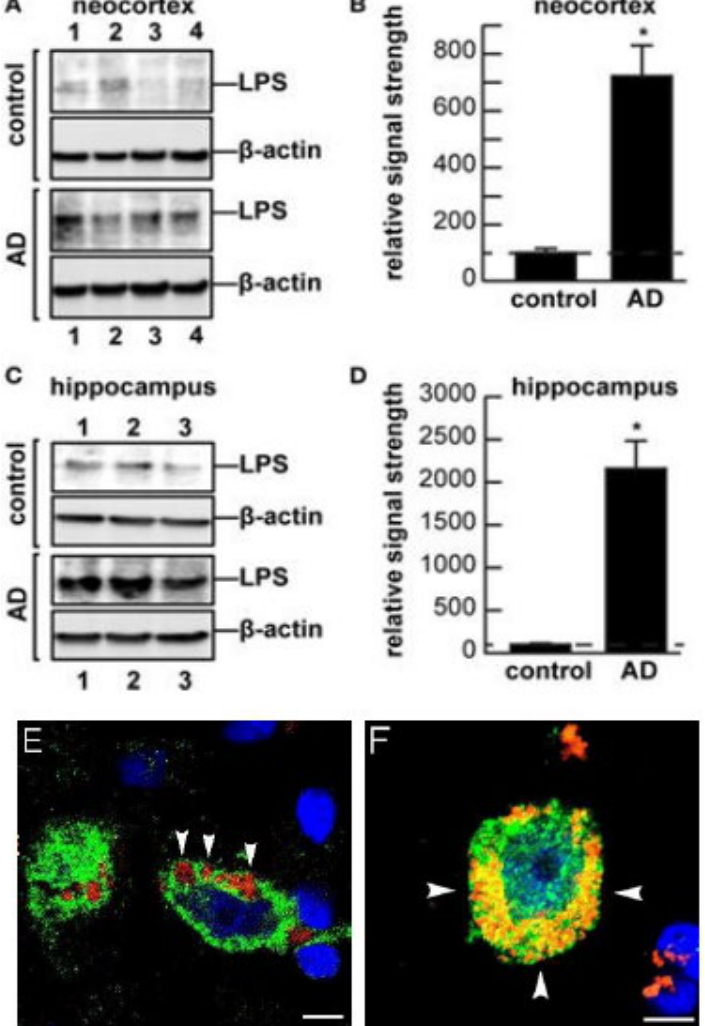
Figure 1. Affinity of LPS for neuronal nuclei in HNG cells and in AD brain . ( A ) Western analysis of lipopolysaccharide (LPS; ~37 kDa) signals in human brain temporal lobe neocortex [N = 4 controls and 4 sporadic Alzheimer’s disease (AD) cases; quantified in ( B )] and in the hippocampus ( C ) [N = 3 controls and N = 3 sporadic AD cases]; quantified in ( D ) compared against β -actin (~42 kDa) abundance in the same samples [using anti- Escherichia coli LPSs (cat# ab35654; Abcam, Cambridge, UK) and anti- β -actin (cat# 3700; Cell Signaling, Danvers, MA, USA)]. Methodologies for Western analysis were previously described [41–43,45,46,49]. * p < 0.05. Densitometric readings of immune-reactive bands were obtained using ImageQuantTL (GE Healthcare, Chicago IL, USA) [12,19,20,41–43]; control and AD tissues were age- and gender-matched; there were no significant differences in age